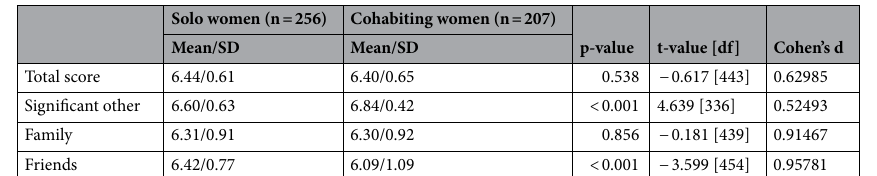
Table 2. Mean scale scores on The Multidimensional Scale of Perceived Social Support (MSPSS) sub-scales and total score 1,2 . 1 All scales ranges between 1 and 7. 2 Student’s t-test.